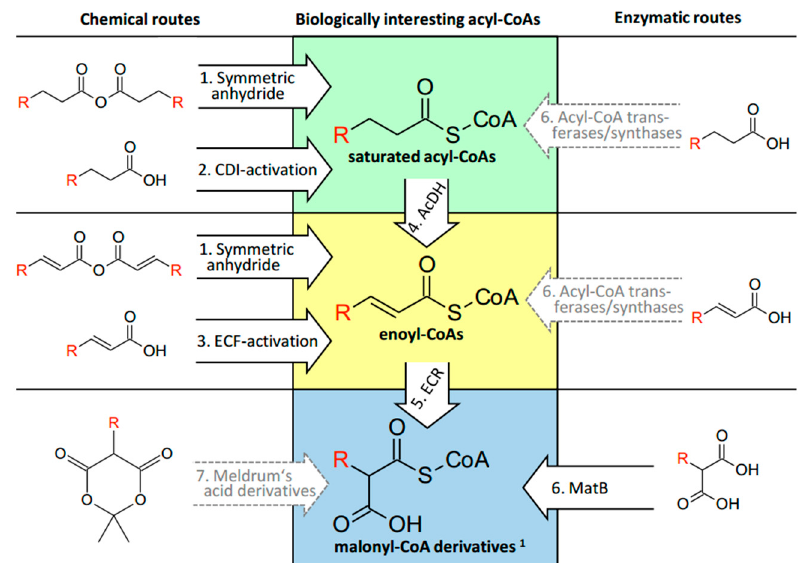
Figure 3. Road map for the synthesis of biologically relevant CoA-thioesters. Shown in bold arrows are the five routes that have been established by our group ( Routes 1 – 4 , this study; Route 5 [8]; Route 6 , this study and [12,13]). These routes give access to all three classes of acyl-CoA esters with high yield and stereoselectivity. Alternative routes that are also discussed in the text are shown with dashed arrows. Abbreviations: AcDH, acyl-CoA dehydrogenases; ECR, enoyl-CoA reductases/carboxylases; MatB, methylmalonyl-CoA synthase. 1 Note that ECR ( Route 5 ) produces the biologically relevant ( S )-malonyl-CoA stereoisomers, whereas matB ( Route 6 ) yields the ( R )-stereoisomers and Meldrum’s acid ( Route 7 ) derivatives a racemic mixture thereof.